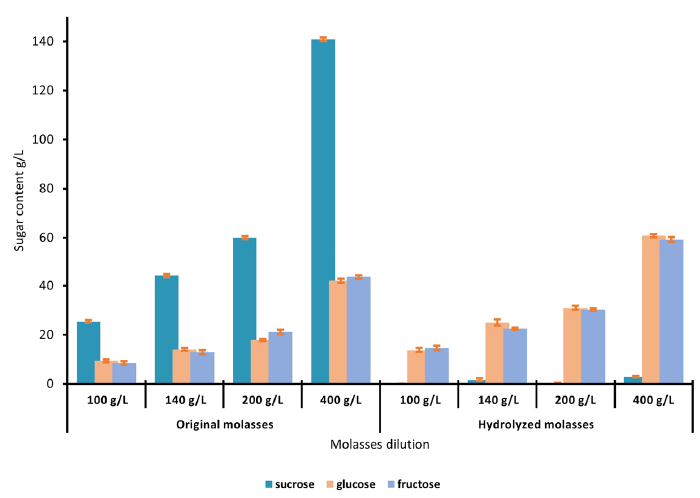
Figure 2. Sugar content g/L (gram/liter) in original and hydrolyzed molasses with previous centrifugation, adjustment to pH 8.5, and subsequent hydrolyzation.